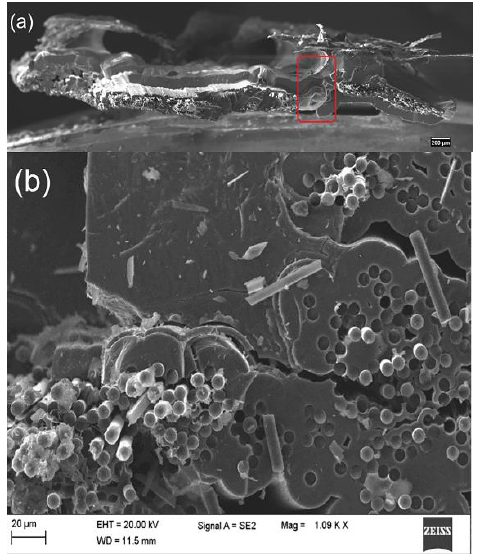
Figure 5. Morphologies and topographies of the fracture section of sample FF_2: ( a ) overall mor- phology of fracture surface; ( b ) local morphology of amplification. ogy of fracture surface; ( b ) local morphology of